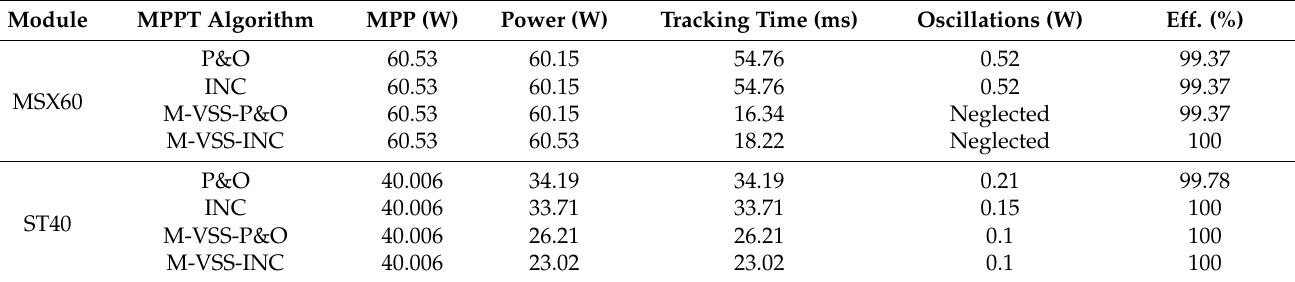
Table 3. Performance of the MPPT algorithms under STC conditions.